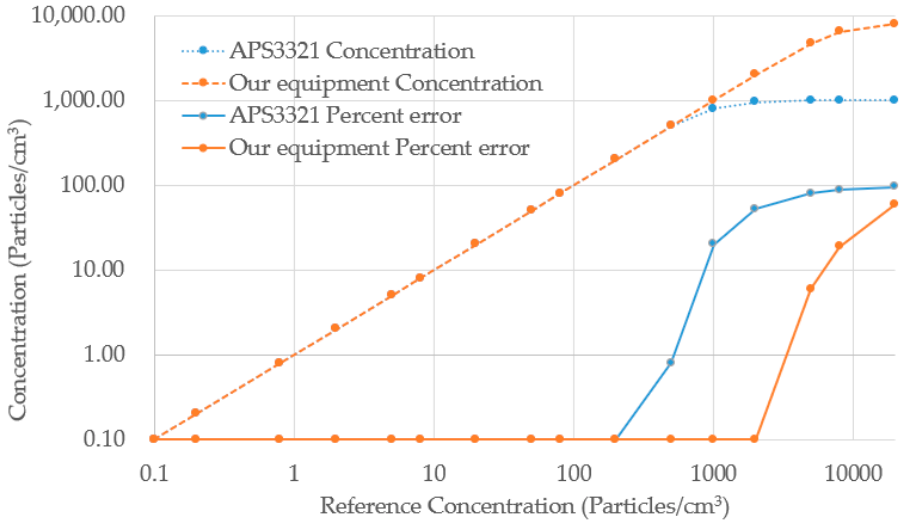
Figure 11. Concentration linearity and percent error of our equipment vs. APS 3321.